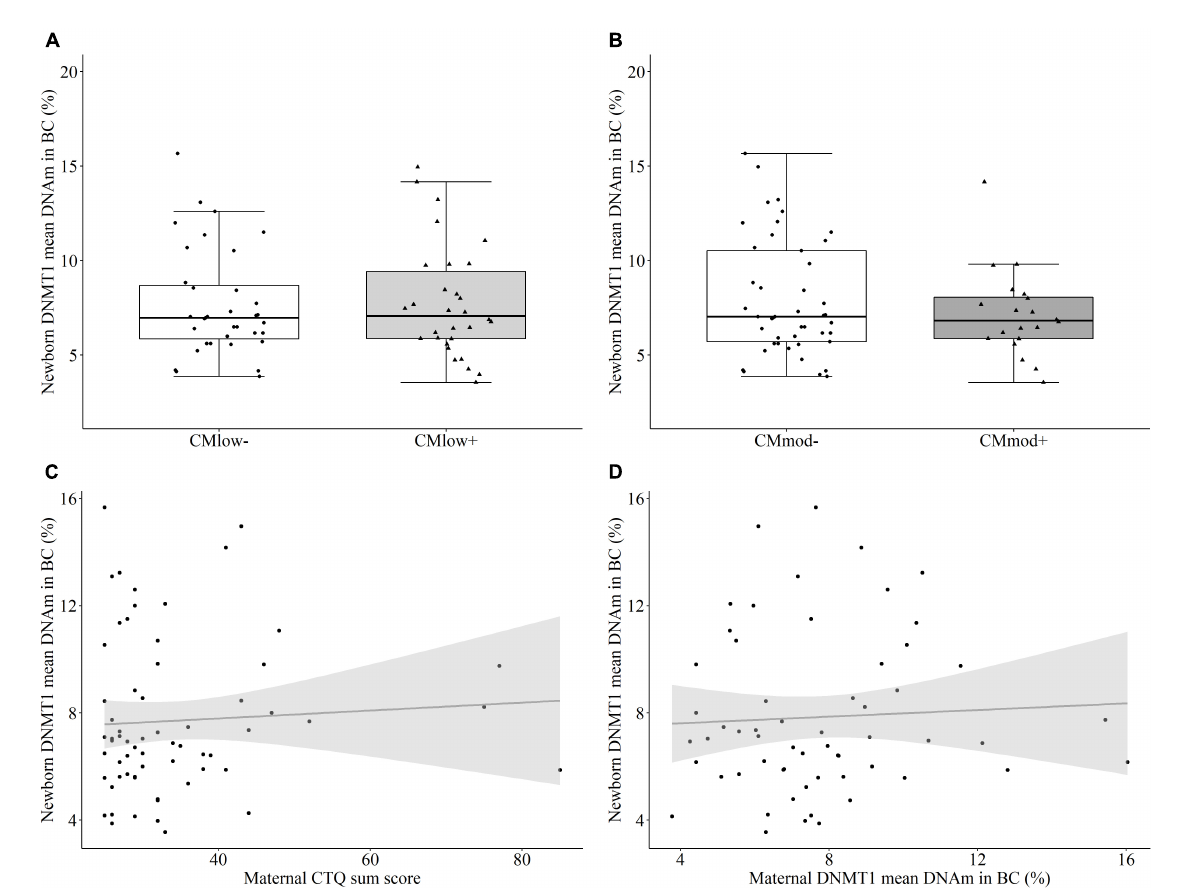
FIGURE6 DNA methyltransferase 1 (DNMT1) mean DNA methylation (DNAm) in buccal cells (BC) of the newborns. (A,B) DNMT1 mean DNA methylation did not differ in newborns with a maternal history of childhood maltreatment (CM) experiences depending on the low cut-off (CM low - versus CM low + ) or moderate cut-off (CM mod - versus CM mod + ). (C) DNMT1 mean DNAm did not have a significant correlation with maternal CTQ sum score ( r s = 0.84, p = 0.505). (D) There was no significant correlation between DNMT1 mean DNAm of mothers and newborns ( r s = 0.061, p =